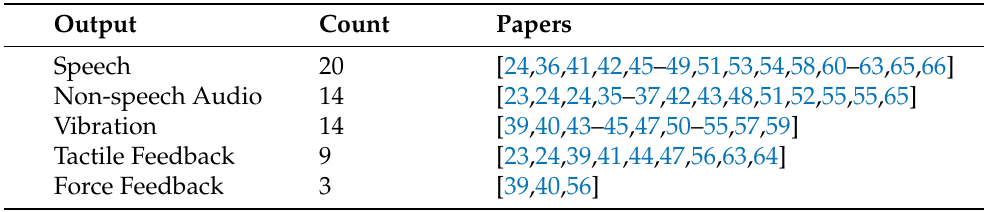
Table 5. Output modalities used for improving images on touchscreen devices.